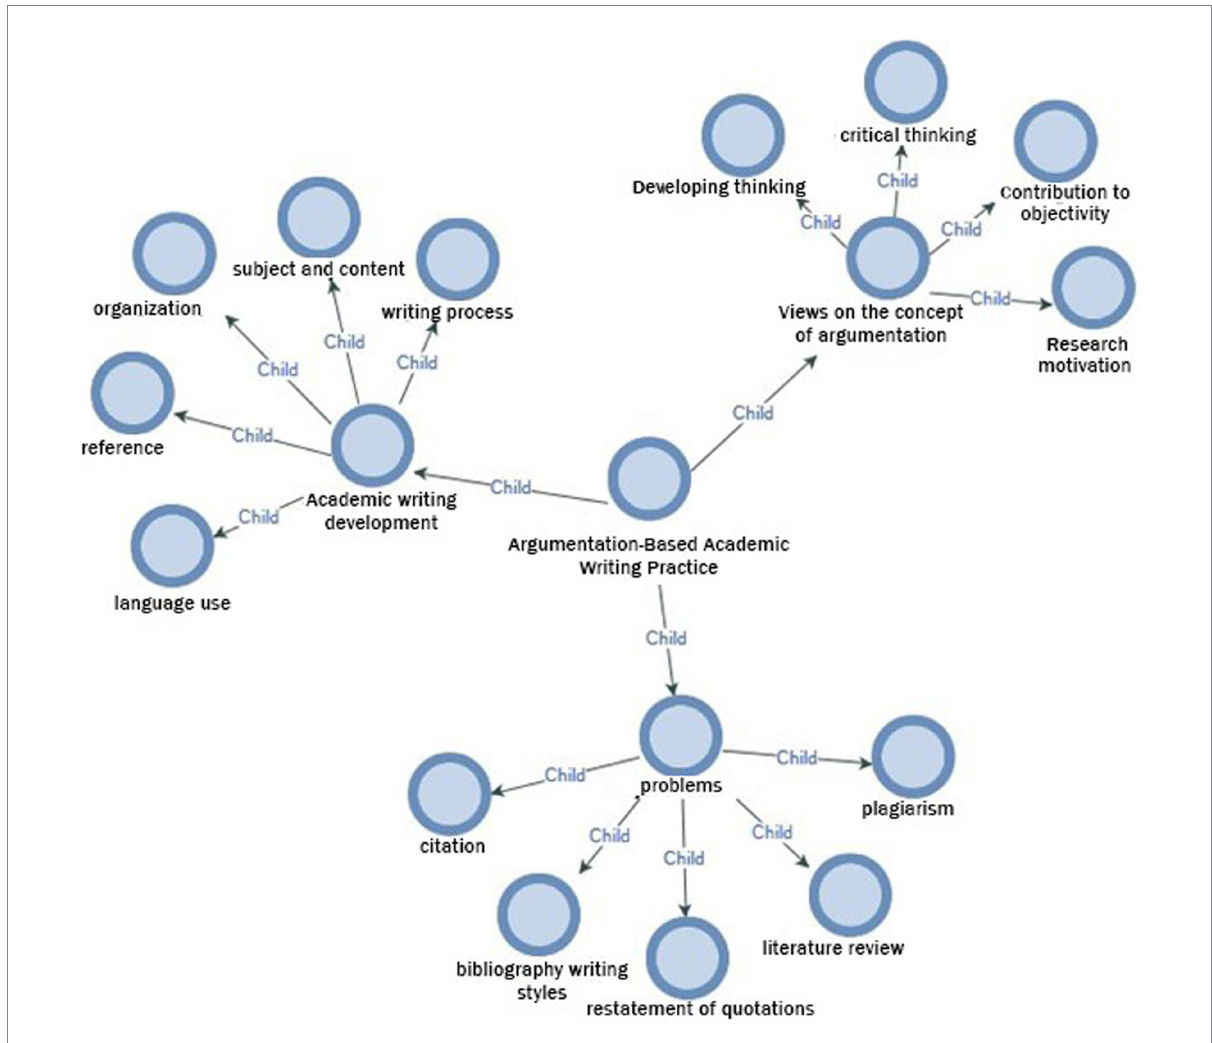
FIGURE 1 A model for student views on argumentation-based academic writing